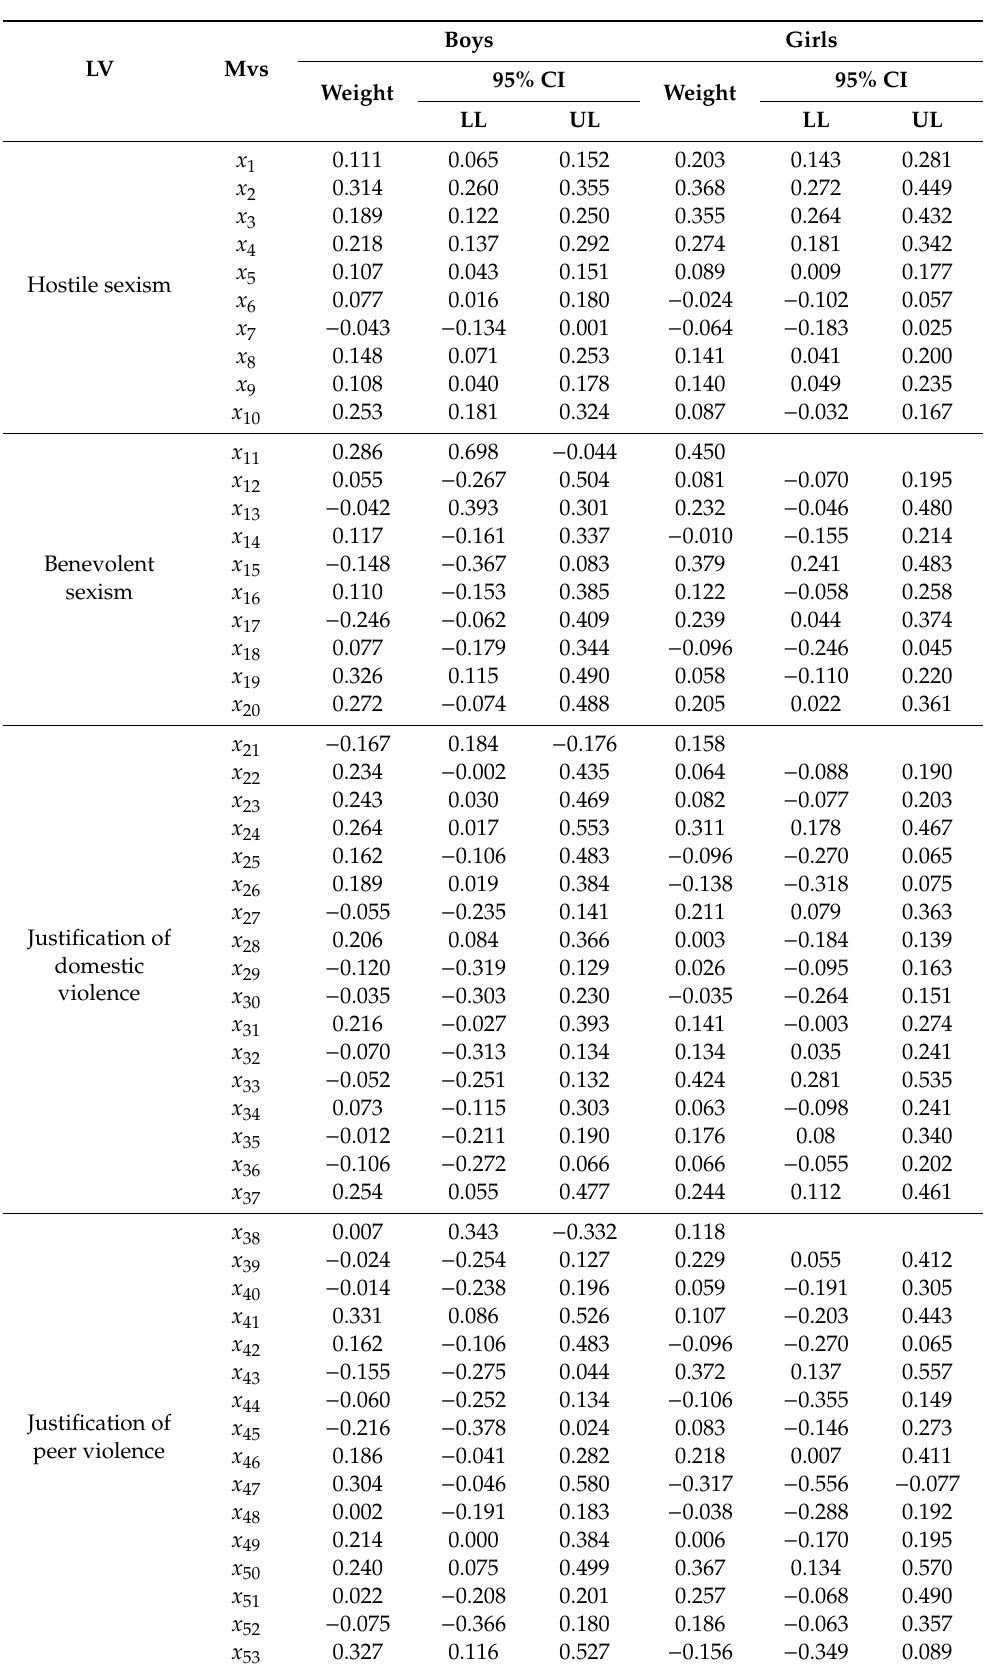
Table A4. Manifest variables for each latent